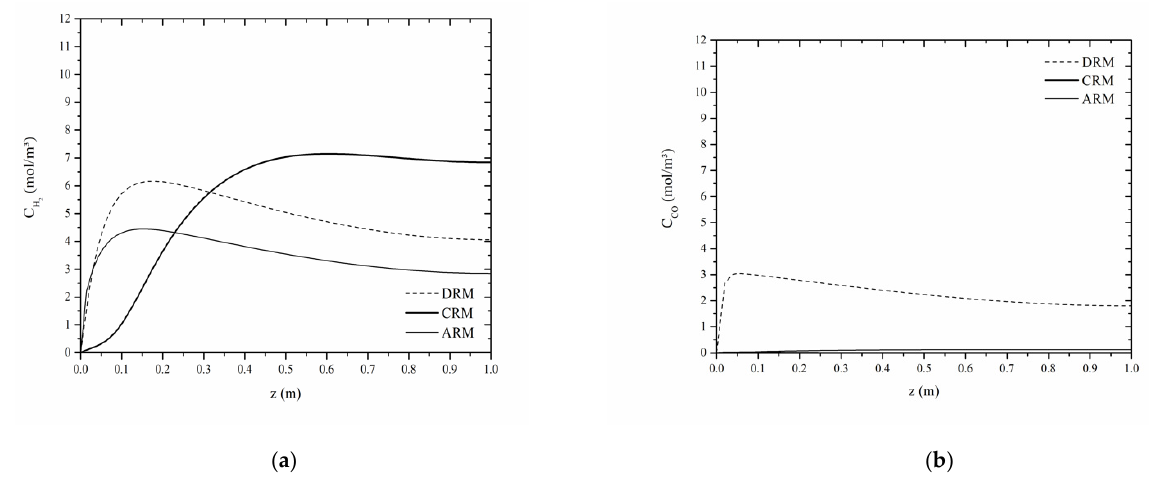
Figure 3. Comparison of alternative methane reform processes. Concentration profiles. ( a ) H 2 , ( b ) CO. Conditions: Cat. Ni (4.82 wt.%)/ γ -alumina, 1023 K, 1.0 bar.